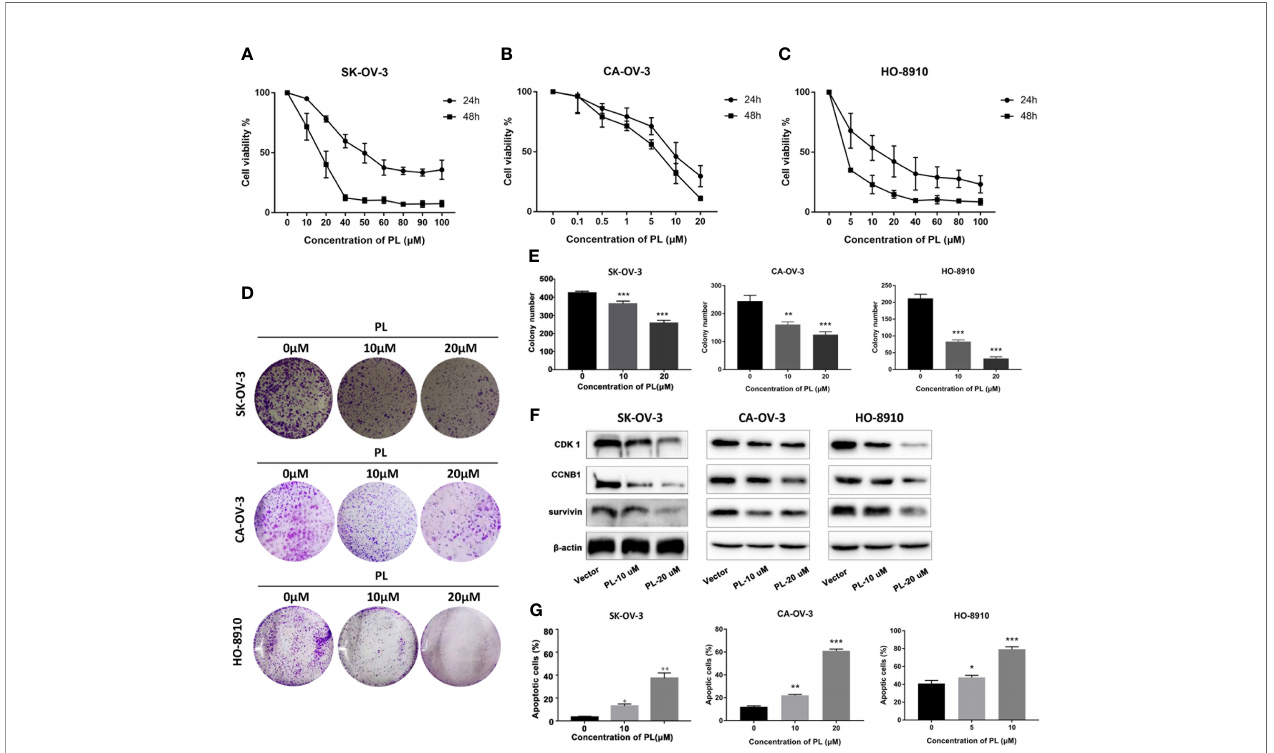
FIGURE 6 | PL inhibited growth and induced apoptosis via targeting CDK1 in EOC cells. (A – C) Cell viability was assessed by MTT assay at 24 h and 48 h after treatment, and IC50 was computed accordingly. (D, E) Cell proliferation capacity was evaluated by colony formation assay, where cells after treatment were plated with a density of 200 cells/well and grown for 7 days followed by staining. (F) Expression levels of CDK1, CCNB1, and survivin proteins after treatment of PL at 10 or 20 µM for 24 h in EOC cells by Western blot analysis. b -Actin was used as an equal loading control for normalization. (G) Apoptotic cells were evaluated by Annexin- V and PI staining and analyzed by fl ow cytometry. All data are shown as mean ± standard deviation (n = 3). One-way ANOVA with the multiple-comparison test was used to calculate statistics: *p < 0.05; **p < 0.01; ***p <